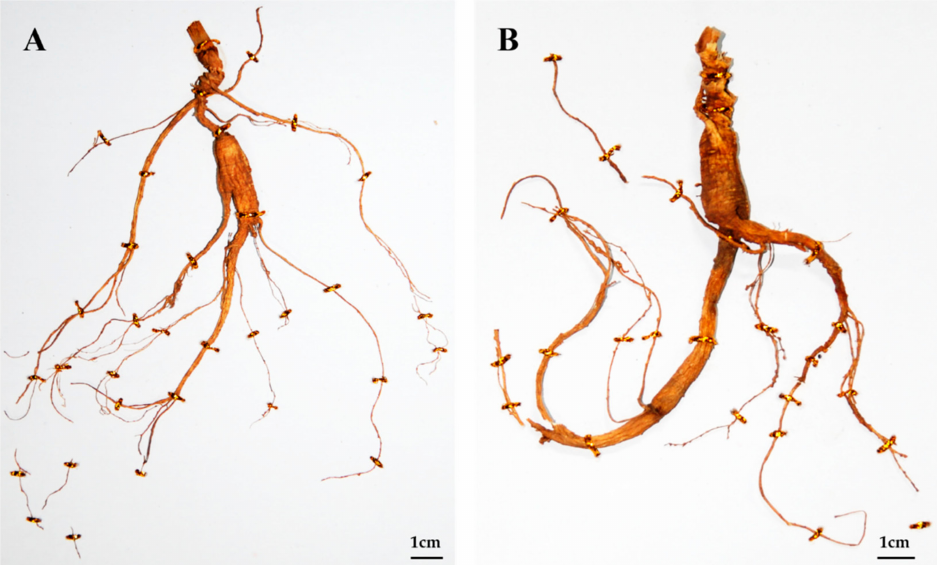
Figure 1. Photographs of two ginseng under forest preserved specimens ( A ) 25-year-old specimen; ( B ) 20-year-old specimen; both were collected in August 2013 and preserved in the Herbarium